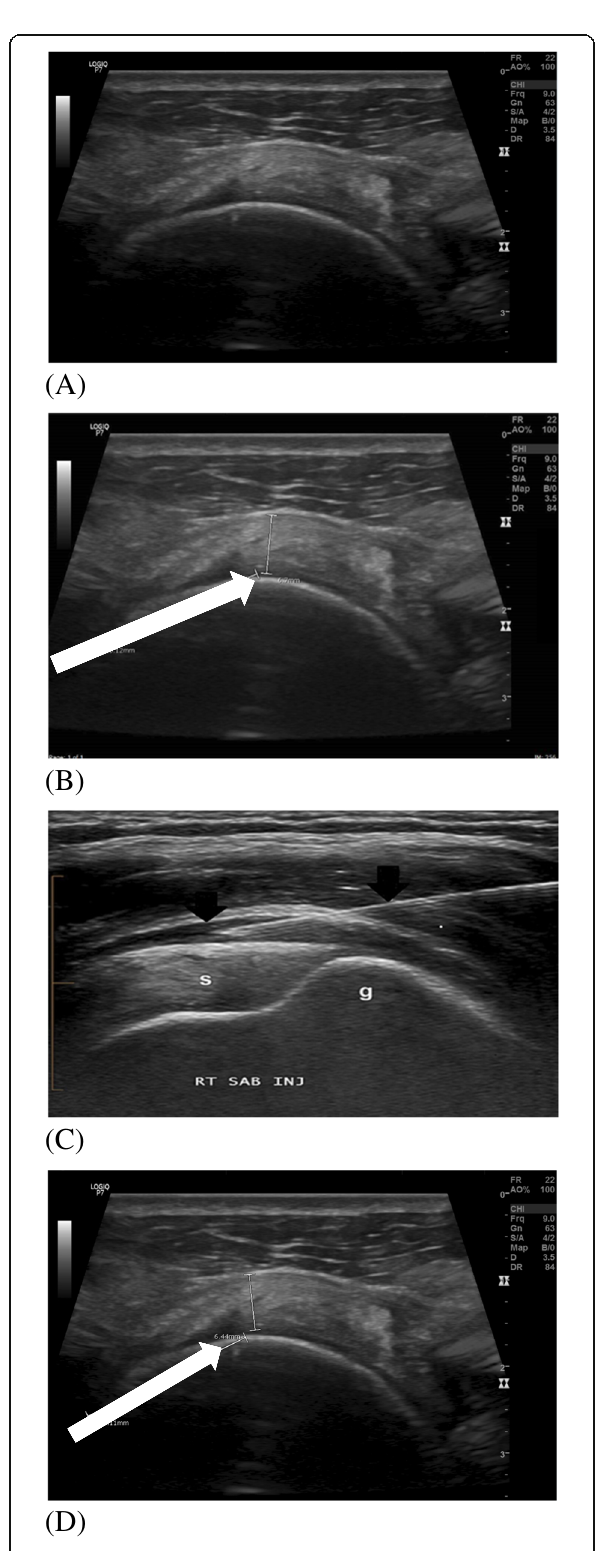
Fig. 7 a Right shoulder ultrasound with diffuse supraspinatus thickening and hypo-echogenicity. b Baseline supraspinatus tendon thickness (white arrow). c Ultrasound-guided injection of the right subacromion bursa (black arrows). d Follow-up supraspinatus tendon thickness after 24weeks (white